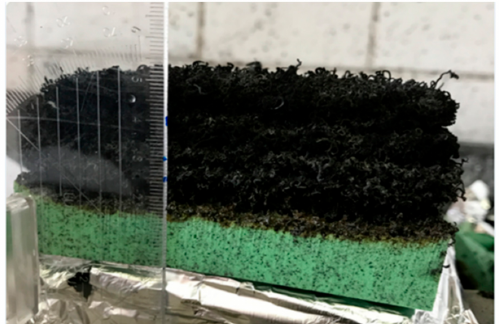
Figure 13. About 3 cm high expanded graphite layer after irradiation of a foam with a thickness of 1.5